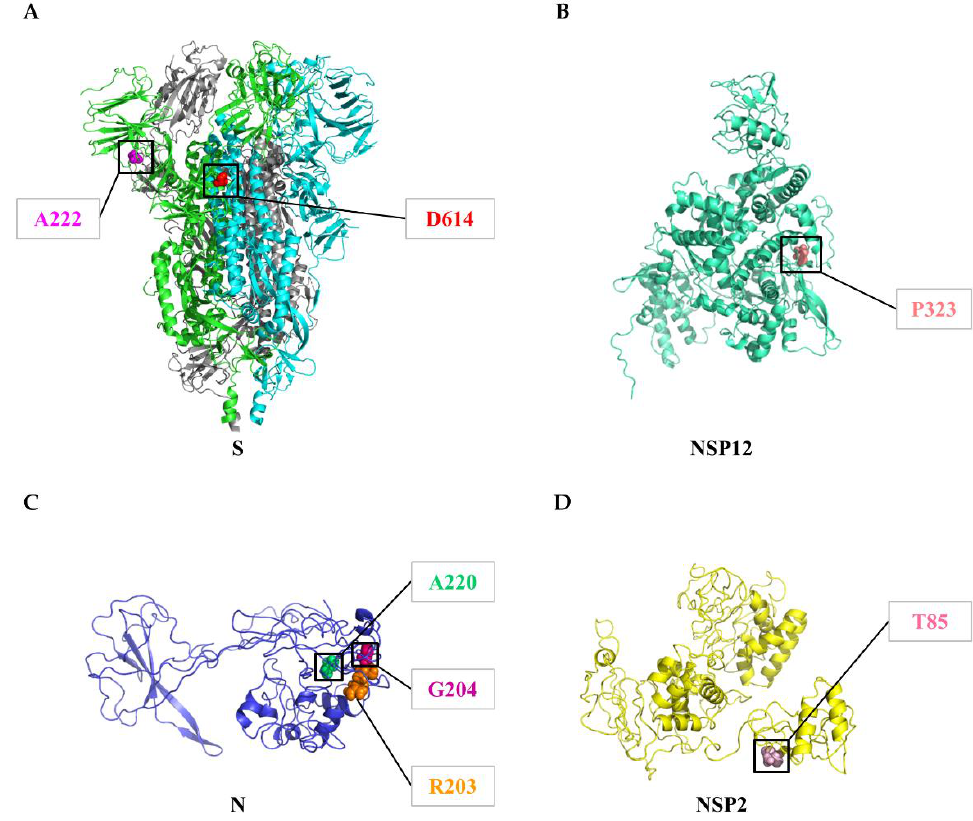
Figure 5. Variants in the SARS-CoV-2 proteins. ( A ) Site 222 (magenta) and Site 614 (red) of spike. Almost all sequences showed a variant (D614G). Site 614 is located at the interface between two subunits. ( B ) Site 323 (deep salmon) of the NSP12 protein. Many sequences showed a variant (P323L). ( C ) Site 203 (orange), Site 204 (hot pink), and Site 220 (lime green) of the nucleocapsid protein. The frequencies of variants R203K, G204R, and A220V were high. ( D ) Site 85 (light pink) of the NSP2 protein. Many sequences showed a variant (T85I). The structures of spike, NSP12, the nucleocapsid protein, and NSP2 were collected from https://zhanglab.ccmb.med.umich.edu/COVID-19/. The protein structural figures were generated by the software PyMOL (http://www.pymol.org/, the accessed date: 16 January 2021). Table 2. The overall prevalence of SARS-CoV-2 variants in a large-scale dataset of 260,673 sequences. Variant frequency (%) Genetic variant Asia Africa Europe North America